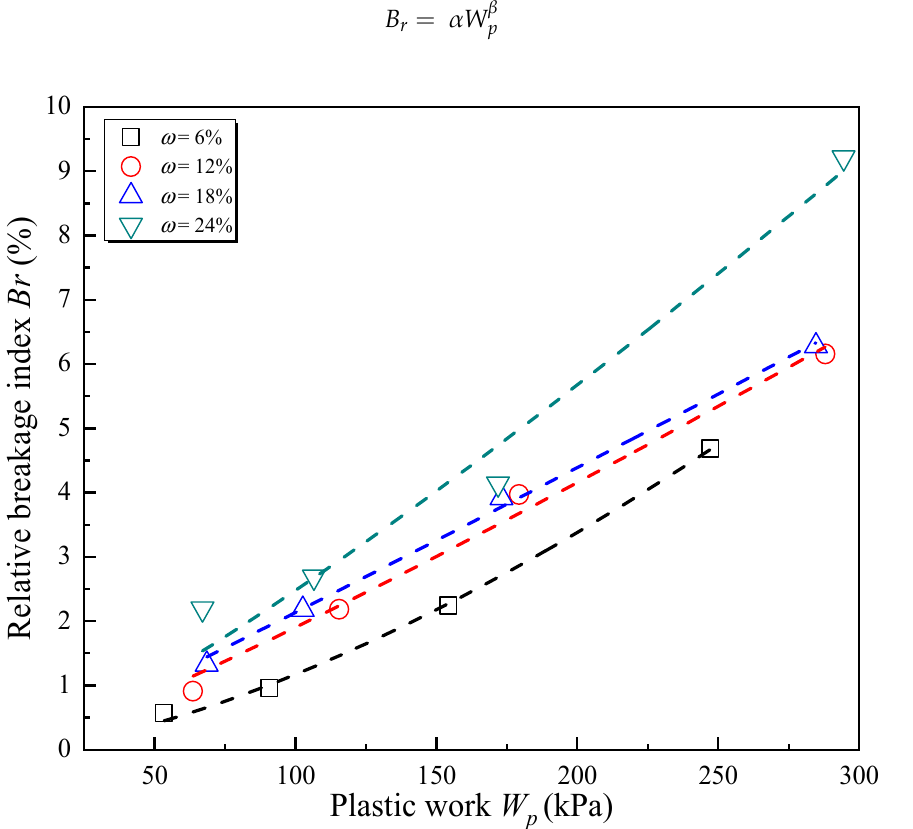
Figure 14. Relationship between relative breakage index and plastic work under different water Figure14. Relationshipbetweenrelativebreakageindexandplasticworkunderdi ff